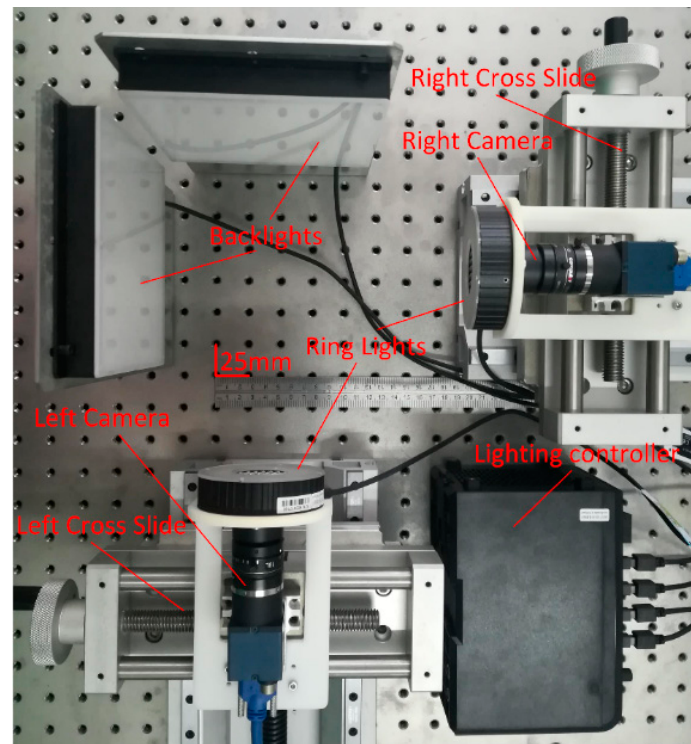
Figure 5. Vision system.